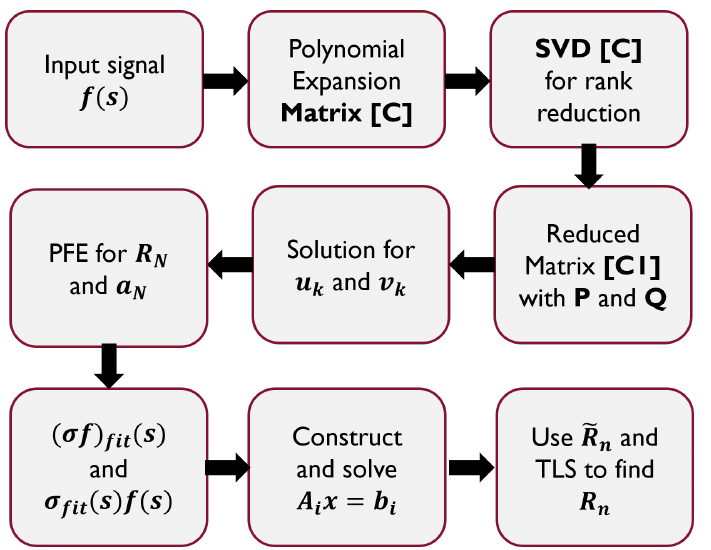
Figure 1. General steps in the VCM algorithm to find CNRs from a frequency domain signal. A reconstructed signal could be compared to the input one for validation